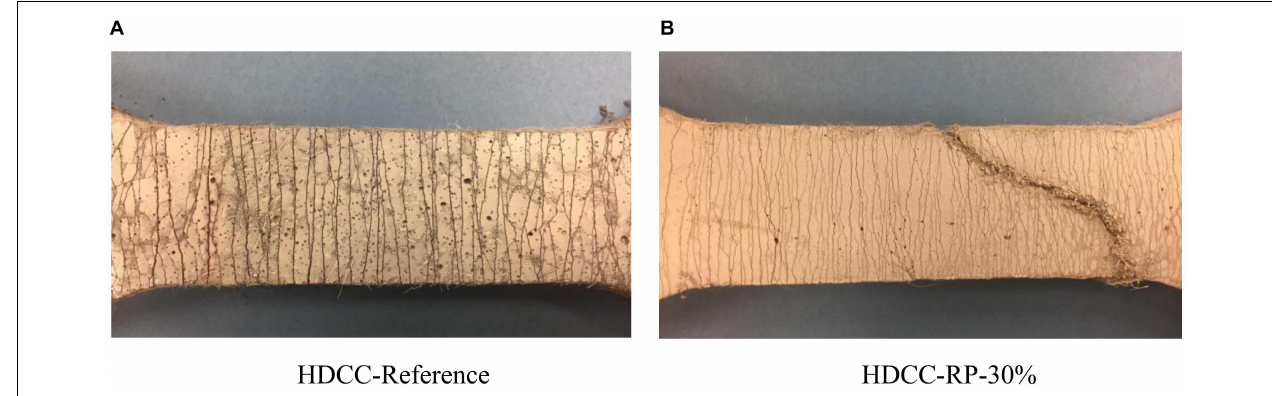
FIGURE 9 | Crack pattern of HDCCs. (A) HDCC-Reference. (B) HDCC-RP-30%.